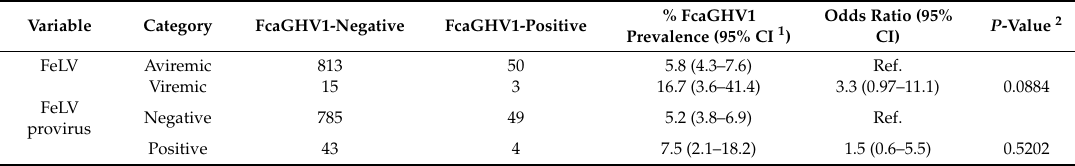
FcaGHV1 and feline leukemia virus (FeLV) infection in the 881 cats presented to Swiss